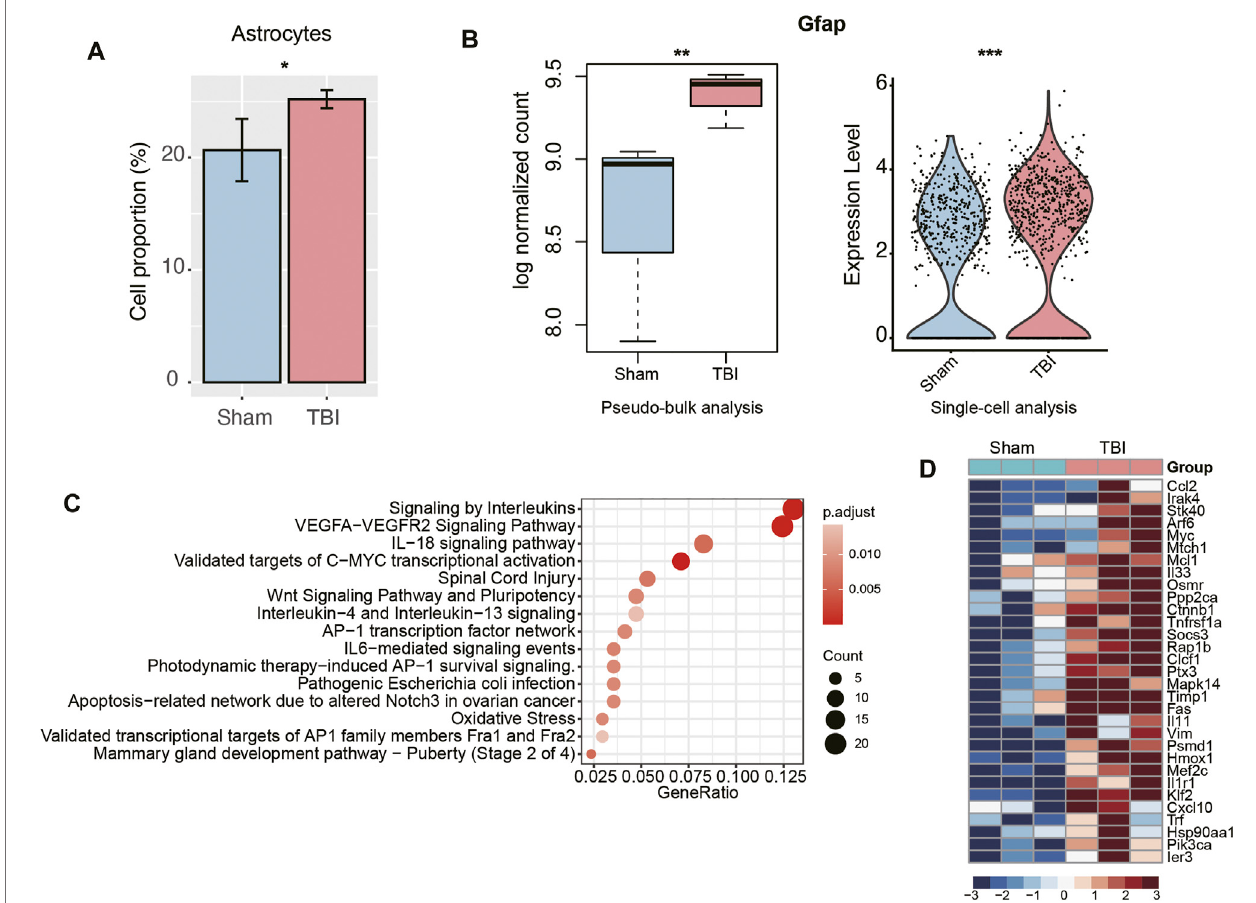
FIGURE 3 | The transcriptional changes of astrocytes of TBI. (A) The relative proportions of astrocytes between TBI and Sham samples. (B) The differential expression levels of Gfap between TBI and Sham samples. The left and right panels illustrated the pseudo-bulk and single-cell analyses, respectively. (C) The pathways enriched by the upregulated genes in the astrocytes of TBI. (D) The key genes upregulated in the astrocytes of TBI.